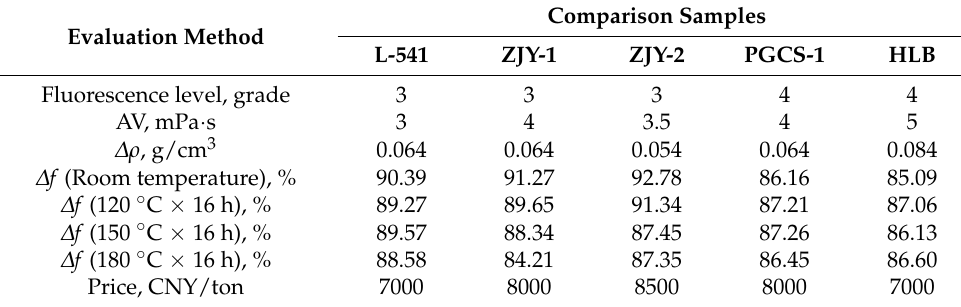
Table 3. Comparative test results of different